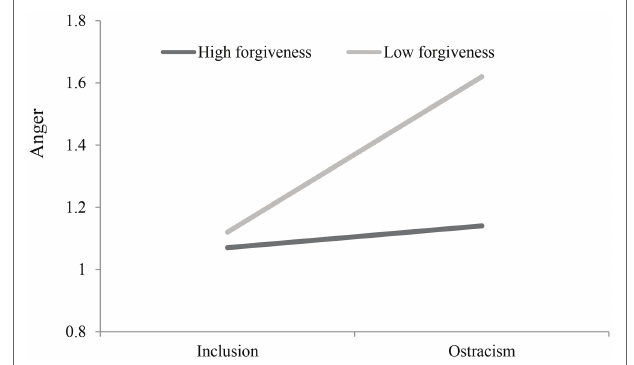
FIGURE 2 | Effects of ostracism and forgiveness on anger in Study